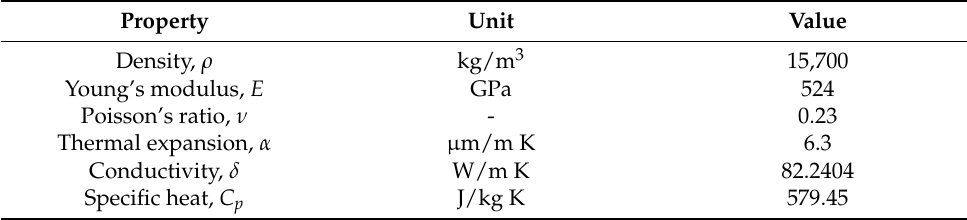
Table 5. Input data for the tool material made of tungsten carbide with 15% cobalt [23].